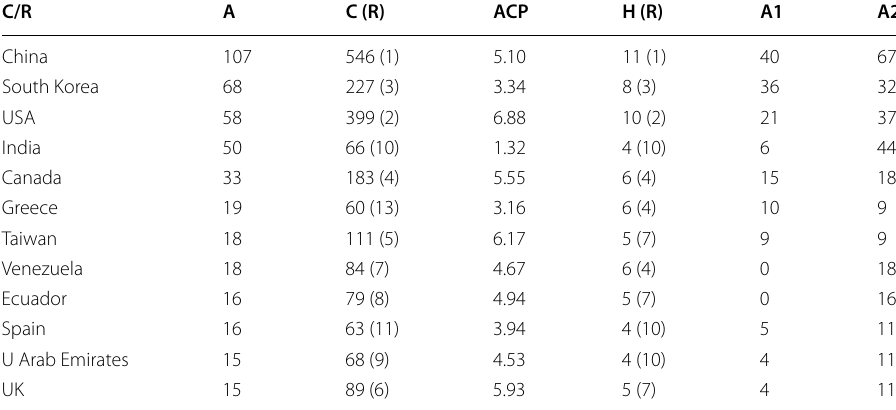
Table 3 Top prolific countries/regions C/R